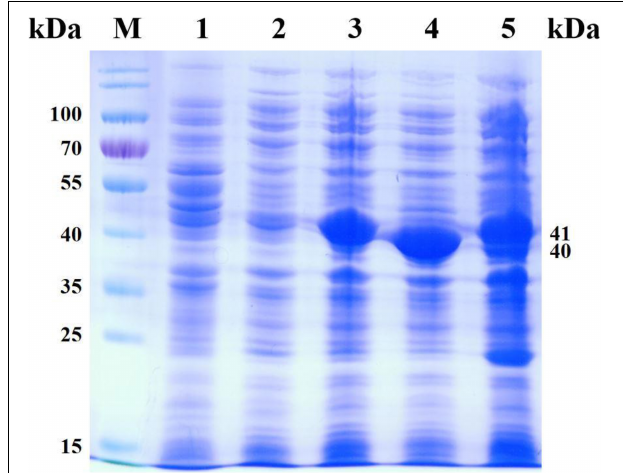
FIGURE 5 | SDS-PAGE analysis for the products of co-express. Lane M, PageRuler Prestained Protein Ladder; lane 1, expression products of E. coli BL21(DE3)/pET28a; lane 2, expression products of E. coli BL21(DE3)/pACYCDuet-1; lane 3, expression products of E. coli BL21 (DE3)/pET28a- Cb FDH; lane 4, expression products of E. coli BL21(DE3)/pET28a- Pf LeuDH; lane 5, expression products of E. coli BL21(DE3)/pACYCDuet-1- Cb FDH- Pf LeuDH:pET28a- Cb FDH.